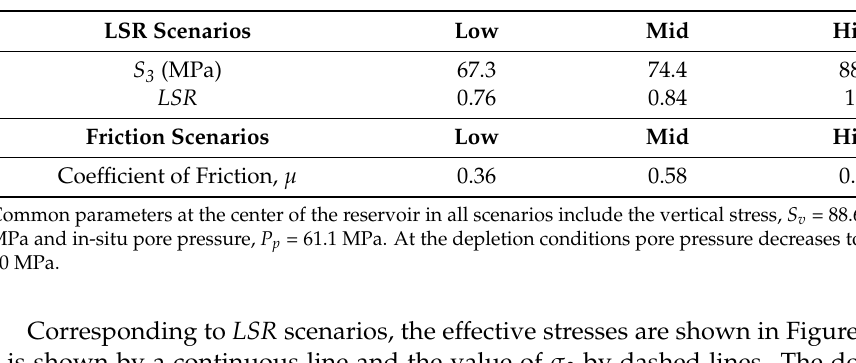
Figure 6. LSR evolution with reservoir depletion assuming different stress paths. 2.2. Elastoplasticity The rock stress-deformation with reservoir depletion is performed with finite ele- ment analysis (FEA) that incorporates an elastoplasticity theory for a nonassociated hard- ening Drucker–Prager material. The use of plasticity provides more accurate estimation of the stress and strain changes in the reservoir and overburden. As it is mentioned earlier, a pure elastic model can lead to significant deviation of the results [10]. The material pa- rameters and functions were derived from calibration of triaxial test data for the sandstone reservoirs and from acoustic velocities and correlation functions for the shale layers. The experimental triaxial test data for the reservoir sandstone are shown by the stress–strain curves of Figure 7 in terms of the axial and radial strains as a function of the applied differential stress. The confinement stress which refers to σ′ 3 represents the mini- mum effective principal stress. A triaxial test at low confining pressure, typically shows a concave stress–strain behavior during initial loading, due to closure of microcracks, with stiffening as the stress increases [15]. The relationships for the Poisson ratio, ν , is given in Equation (3) and the Young mod- ulus, E is calculated from Equation (4) as Δσ ′ 2 = Δσ ′ 3 = 0, (cid:2021) = − (cid:1986)(cid:2013) (cid:2871) (cid:1986)(cid:2013) (cid:2869) (3) (cid:1831) = (cid:1986)(cid:2026)′ (cid:2869) − (cid:2021)((cid:1986)(cid:2026)′ (cid:2870) + (cid:1986)(cid:2026)′ (cid:2871) ) (cid:1986)(cid:2013) (cid:2869)